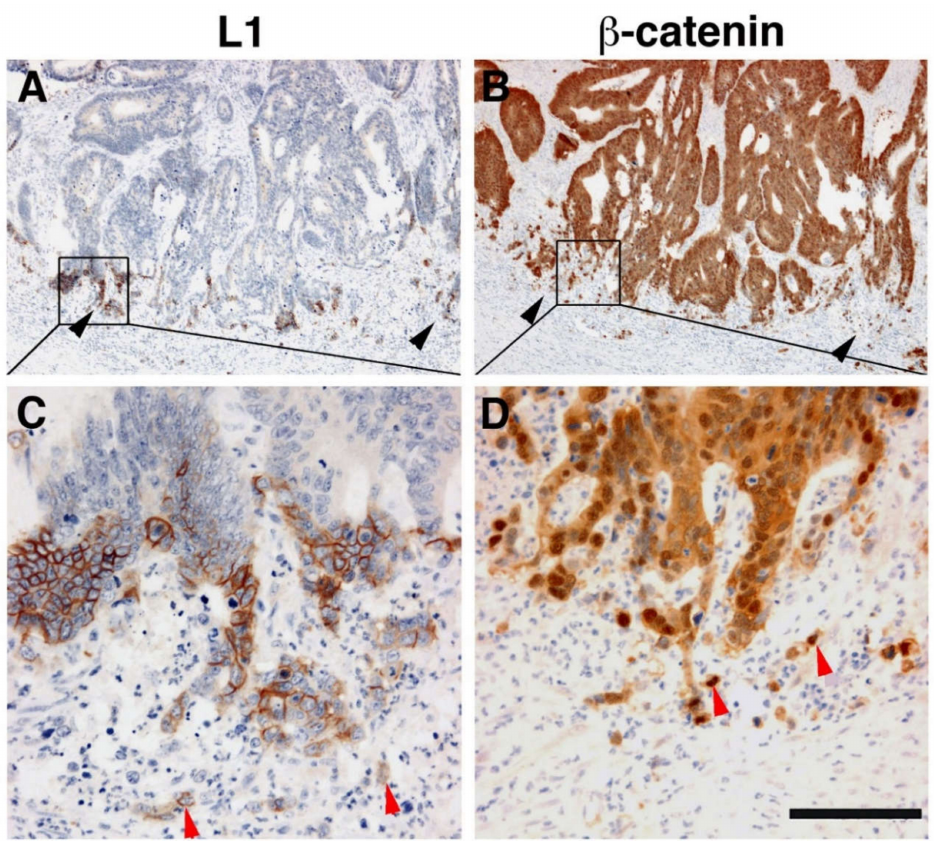
Figure 2. L1 is exclusively expressed at the invasive front of human colorectal cancer (CRC) tissue in cells expressing β -catenin in their nuclei. ( A ) Immunohistochemical staining of human CRC tissue for L1. Note the preferential localization of L1 in invasive areas of the tumor (black arrowheads), but not in the inner more di ff erentiated areas of the tumor. ( B ) In contrast to L1 localization, a serial tissue section stained with anti β -catenin antibody displays a uniform staining of the same CRC tissue area. ( C ) Enlarged picture of the boxed area in ( A ) showing the membranal localization of L1. Single CRC cells invading into the stroma could also be seen (red arrowheads). ( D ) Magnified picture of the boxed area shown in ( B ) localizing β -catenin staining in both the cytoplasm and nuclei of CRC tissue cells and in the nuclei of single invasive cells (red arrowheads) at the tumor tissue edge [19]. Scale bar: ( A , B ) 375 µ m, ( C , D ) 75 µ